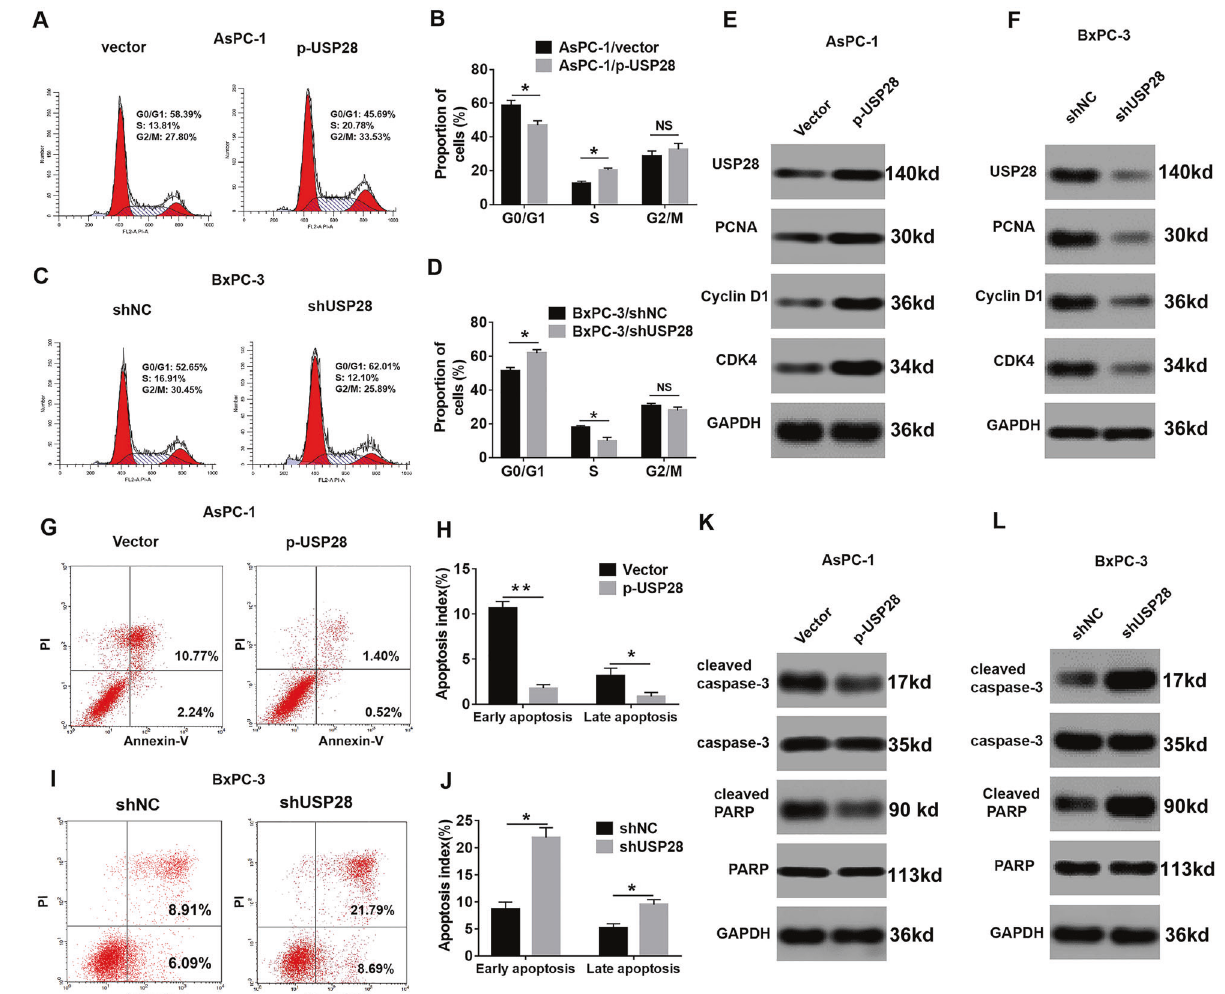
Fig. 3 USP28 accelerates cell-cycle progression and inhibits cell apoptosis. A – D Detection for cell cycle of PC cells following overexpression or knockdown of USP28, respectively. Results are expressed as peak diagram ( A , C ) and calculated distribution for cells in G0/G1, S and G2/M phases ( B , D ). Data represent mean ± SD of triplicate experiments and were statistically analysed with Student ’ s t test, * P < 0.05. E , F Western blotting showing the protein expression of USP28, PCNA, cyclin D1 and CDK4 in USP28-overexpression AsPC-1 cells ( E ) or USP28-silencing BxPC-3 cells ( F ). GAPDH was used as a loading control. G , H Results are expressed as scatter diagram for measurement of apoptotic cells ( G ) and calculated percentage of annexin-V-positive cell population ( H ) in USP28-overexpression cells. The data represent mean ± SD from